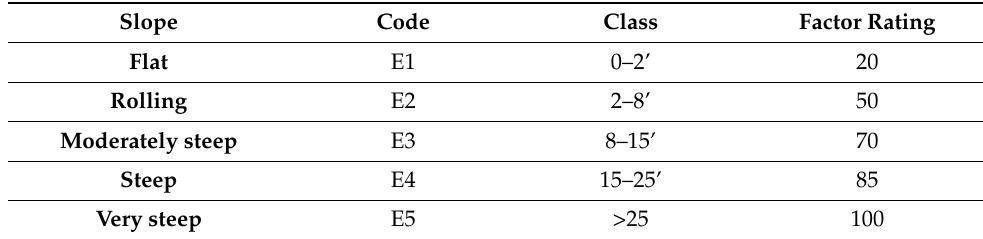
Table 4. Factor ratings of slope